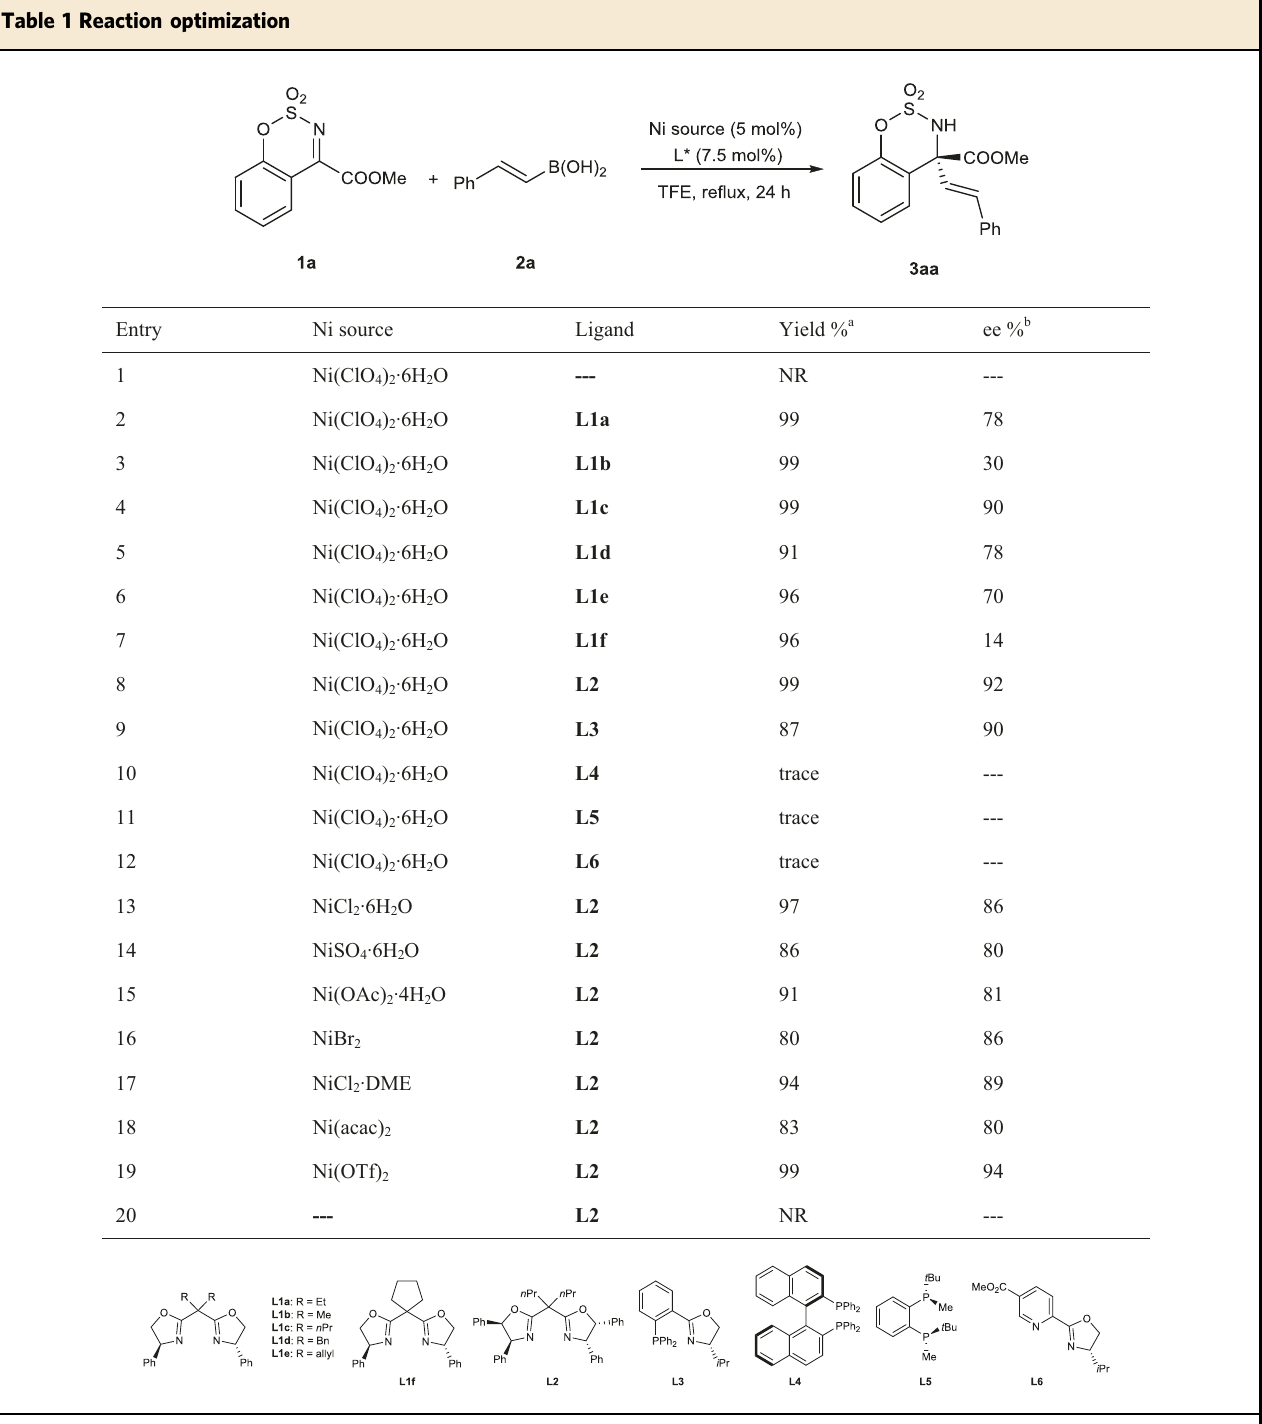
Table 1 Reaction